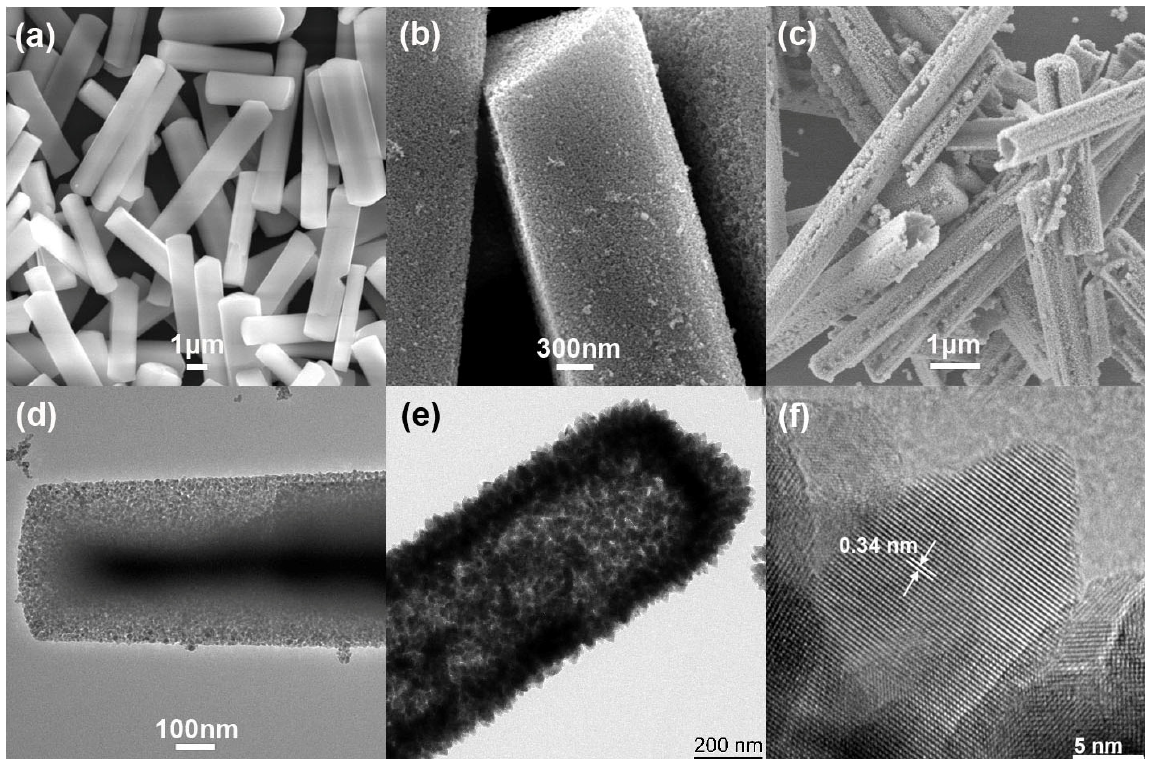
Figure 2. ( a – c ) SEM images of samples; ( d , e ) TEM images of CdS MRs and CdS HRs; ( f ) HRTEM image of CdS HRs.